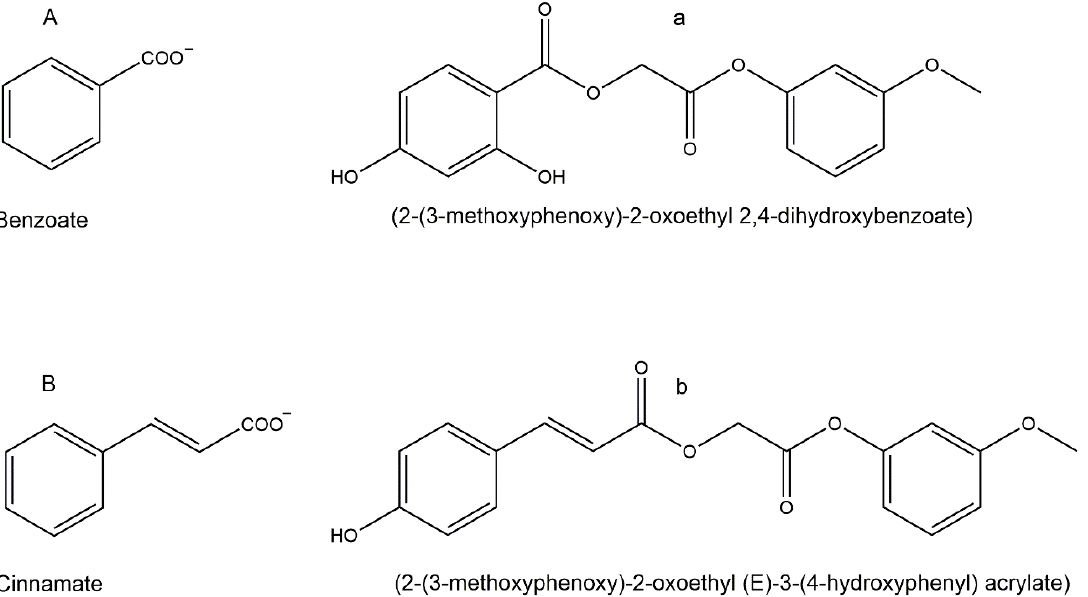
experimental data on the effect of substrate concentration at different inhibitor concentrations.